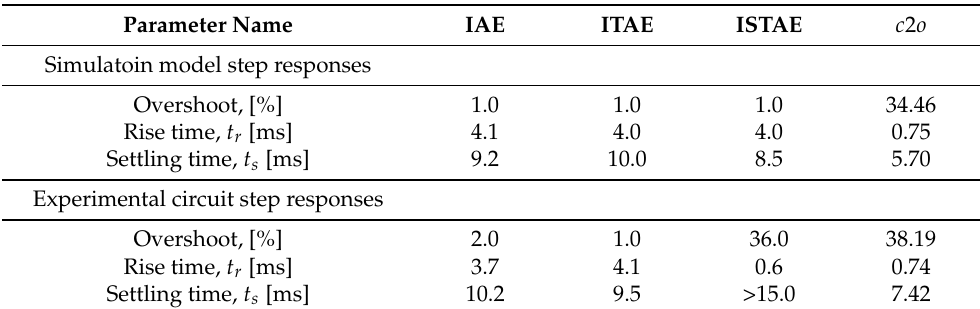
Table 5. Selected parameters of step responses from Figure 10 for gains obtained with global stability constrained GA optimization, Table